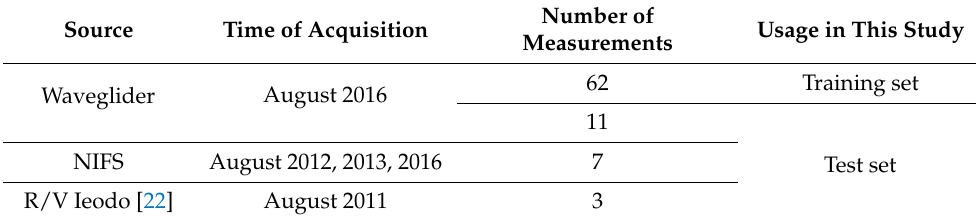
Table 1. Summary of the dataset used in this